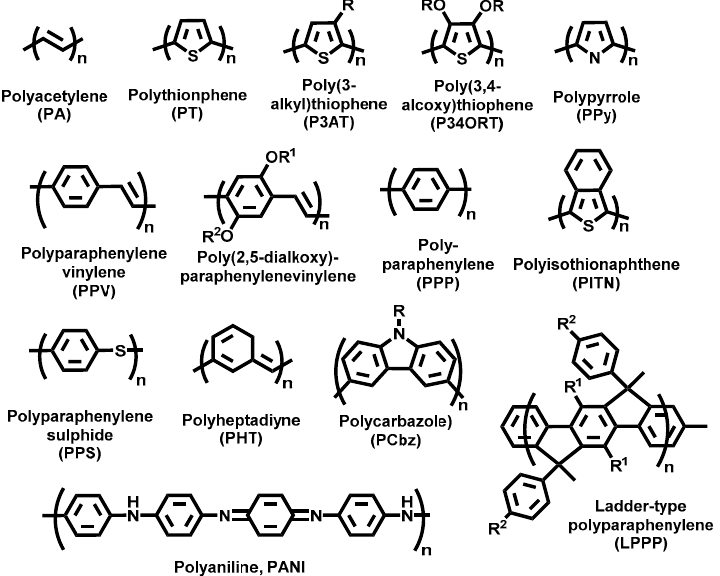
Figure 1. Chemical structures of the most known families of conducting